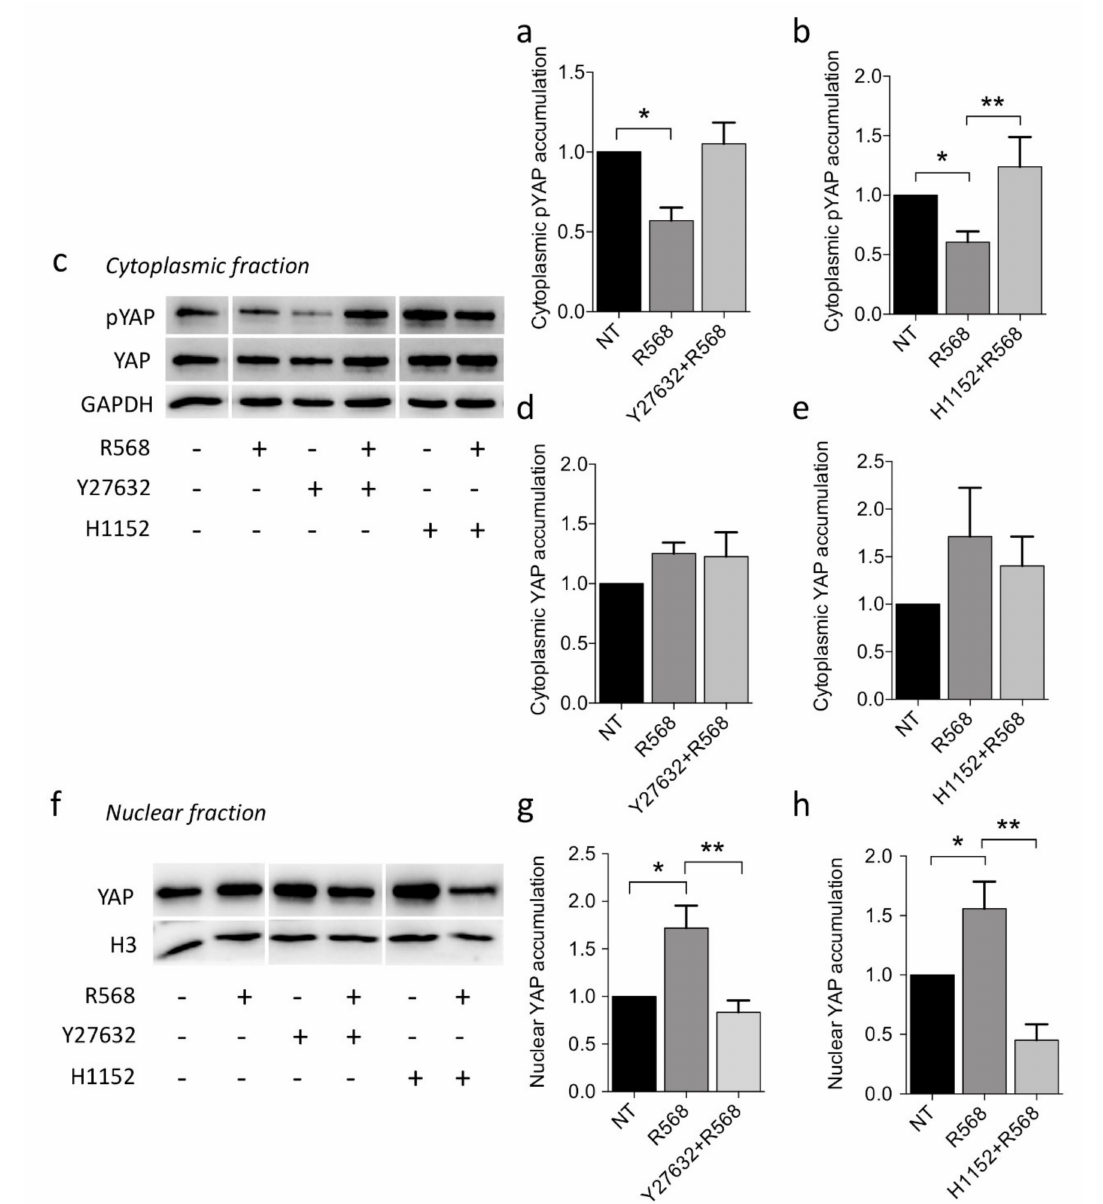
Figure 6. YAP1 modulation is coupled with CASR activation through RhoA/rho-associated protein kinase (ROCK) signaling in CASR-HEK293A cells. ( a – e ) Phosphorylated (panels a – c ) or total (panels c – e ) cytoplasmic YAP1 (pYAP1) expression in CASR-HEK293A cells incubated for 1 h with R568 and the ROCK inhibitors Y27632 (panel a , 10 µ M; * p = 0.006) or H1152 ( b , 1 µ M; * p = 0.014; ** p = 0.083). A representative Western blot is shown in panel c . ( f – h ) CASR-HEK293A cells were incubated with the ROCK inhibitors Y27632 (panel h , 10 µ M; *, p = 0.057; ** p = 0.047) and H1152 (panel h , 1 µ M; * p = 0.051; ** p = 0.020 by one-way ANOVA). Then nuclear YAP1 accumulation was analyzed by Western blotting and quantified by densitometric analysis. Bars, mean ± SEM ( n = 3); p -values are from one-way